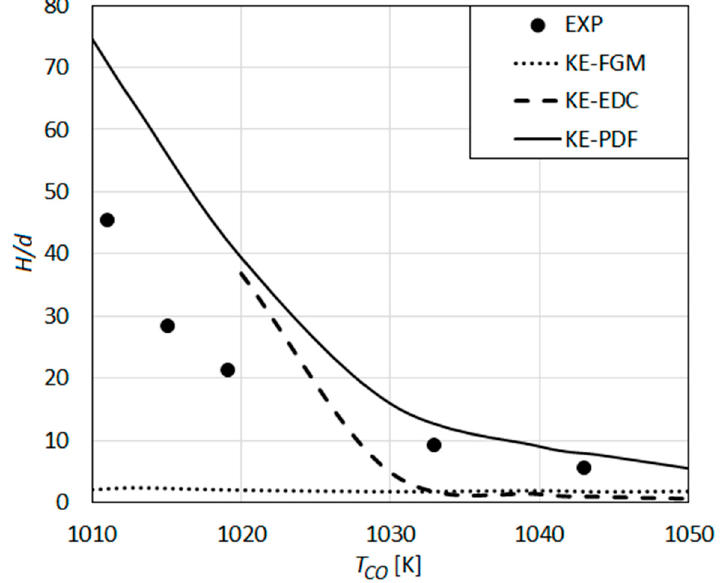
Figure 12. Lift-off height as a function of co-flow temperature: Predictions using the detailed reaction mechanism of Keromnes et al. [61] compared with the measurements of Wu et al. [23].